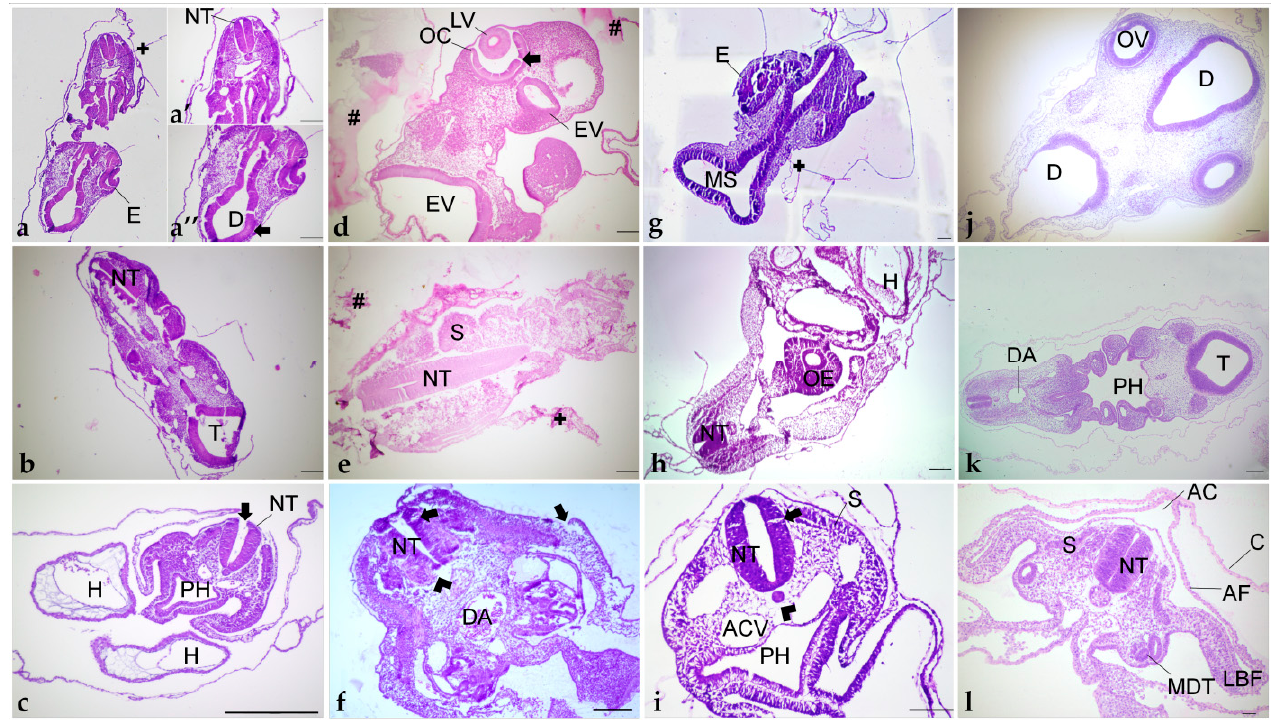
Figure 7. Different orientations of histological sections obtained of embryos embedded in paraplast ( a – c ); paraplast with pre-embedding in agar–gelatin ( d – f ); PEG ( g – i ); and historesin ( j – l ). ( a , d , g , j ) Cephalic region. ( b , e , h , k ) Cervical region. ( c , f , i , l ) Trunk region. ( a’ ): Cervical portion. ( a” ): Cephalic portion. AC: Amniotic cavity. ACV: Anterior cardinal vein. AF: Amniotic fold. C: Chorion. D: Dien- cephalon. DA: Dorsal aorta. E: Eye. EV: Encephalic vesicle. H: Heart. LBF: Lateral body folds. LV: Lens vesicle. MDT: Mesonephric duct and tubule. MS: Mesencephalon. NT: Neural tube. OC: Optic cup. OV: Optic vesicle. OE: Oesophagus. PH: Pharynx. S: Somite. T: Telencephalon. +: Detachment. #: Agar–gelatin residue. Arrowhead: Shrinkage. Arrow: Disruption. Staining: H&E. Scale bar = 100 µm. Pre-embedding in agar was performed before the paraplast embedding to improve embryo orientation. The first attempt with a pre-embedding solution of 2% agar and 2.5% was not efficient because the drops of agar–gelatin dissolved in the storage solutions (NaCl 0.9% or ethanol 70%), and the blocks prepared on the polyethylene molds dissolved in the 0.9% NaCl solution. Posterior clarification with xylene dissolved these blocks, and amyl acetate made them opaque, and it was impossible to see embryo orientation. In try- ing to prevent the block from dissolving in xylene, the concentration of agar and gelatin was increased to 4% and 5%, respectively, but due to the formation of lumps, it was not used. Thus, agar concentration was reduced to 2%, with gelatin maintained at 5%, and these blocks resisted xylene clarification but also became non-transparent. To overcome this matter and enable embryo orientation, the anterior portion of the block was stained with eosin. However, the color vanished during processing. Thus, with this method,